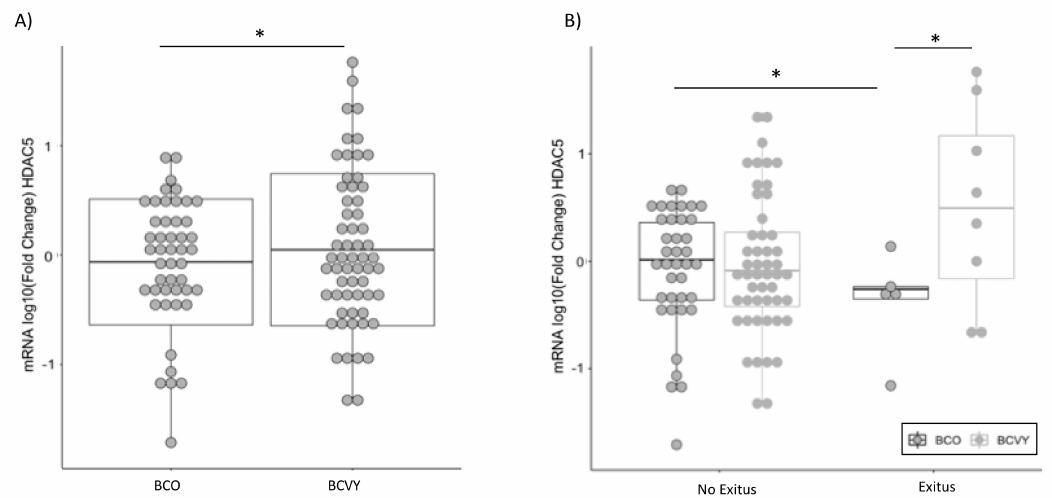
Figure 1. HDAC5 expression in BCVY (n = 60) and BCO (n = 47) patients analyzed by qRT-PCR ( A ). HDAC5 expression in BCVY and BCO patients regarding their status (exitus or no exitus) ( B ). BCVY: Breast cancer in very young women; BCO: Breast cancer in old women. * p ≤ 0.05, ** p ≤ 0.01.